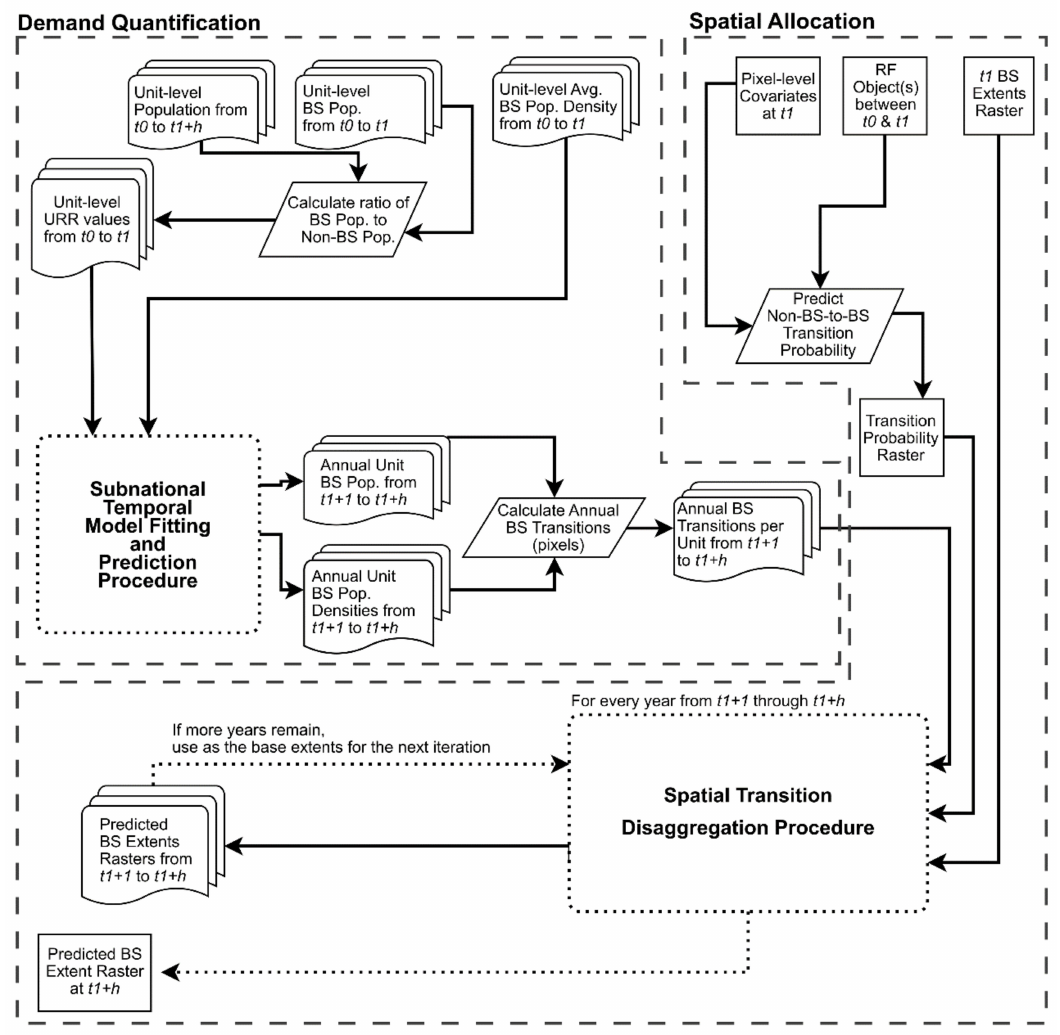
Figure A1. Full process diagram for the Built-Settlement Growth Model—extrapolation (BSGMe) as broken down into the “Demand Quantification” procedure and the “Spatial Allocation Procedure”. For details on the “Spatial Transition Disaggregation Procedure”, readers are referred to Nieves et al. [16]. For details on the “Subnational Temporal Model Fitting and Prediction Procedure”, readers are referred to Appendix A, Figure